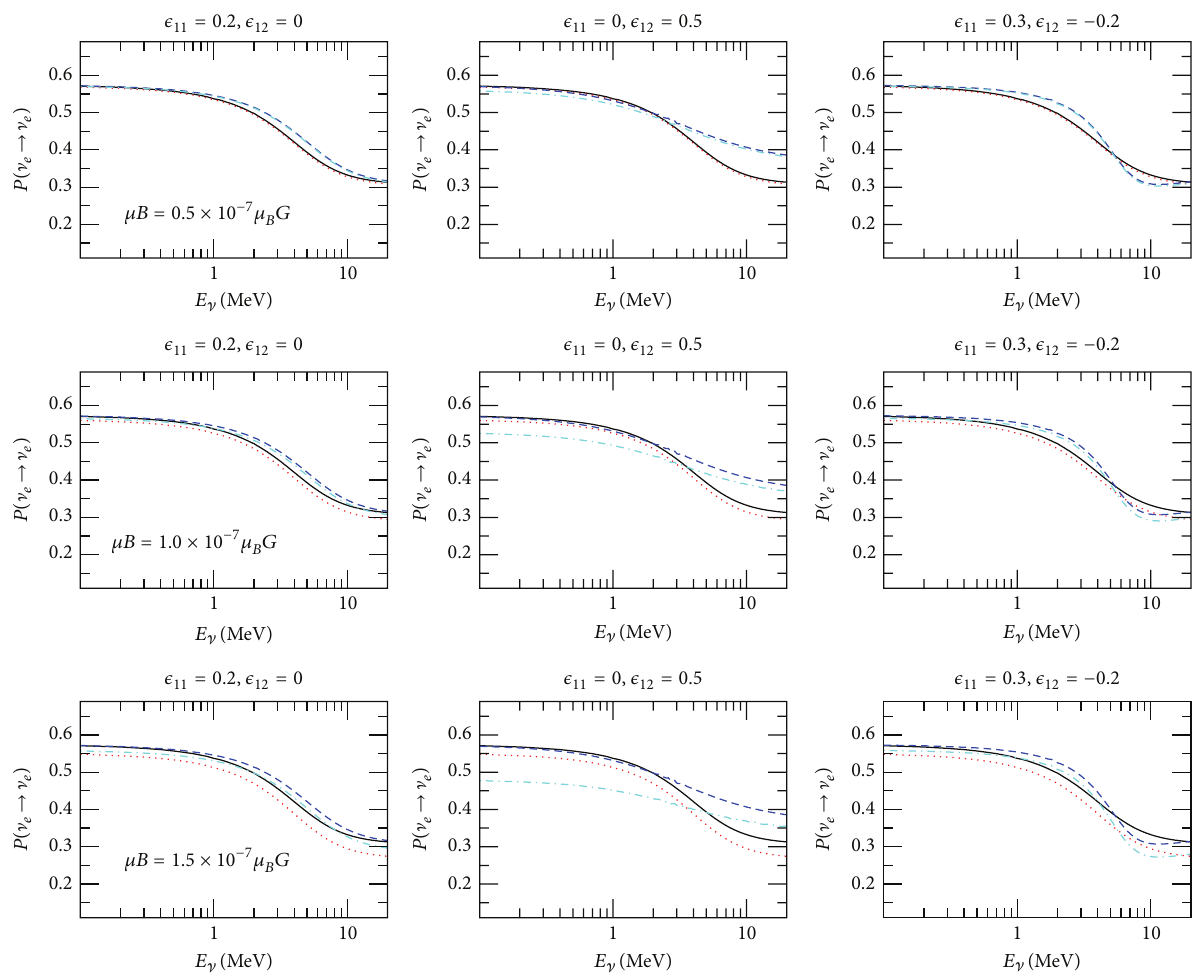
Figure 2: Survival probabilities for MSW-LMA prediction alone (solid lines), SFP effect at different 𝜇𝐵 values (dotted lines), NSI effect alone (dashed lines), and the combined effect of the NSI and SFP (dotted-dashed lines). Each column uses the same 𝜖 11 and 𝜖 12 values, and each row uses the same 𝜇𝐵